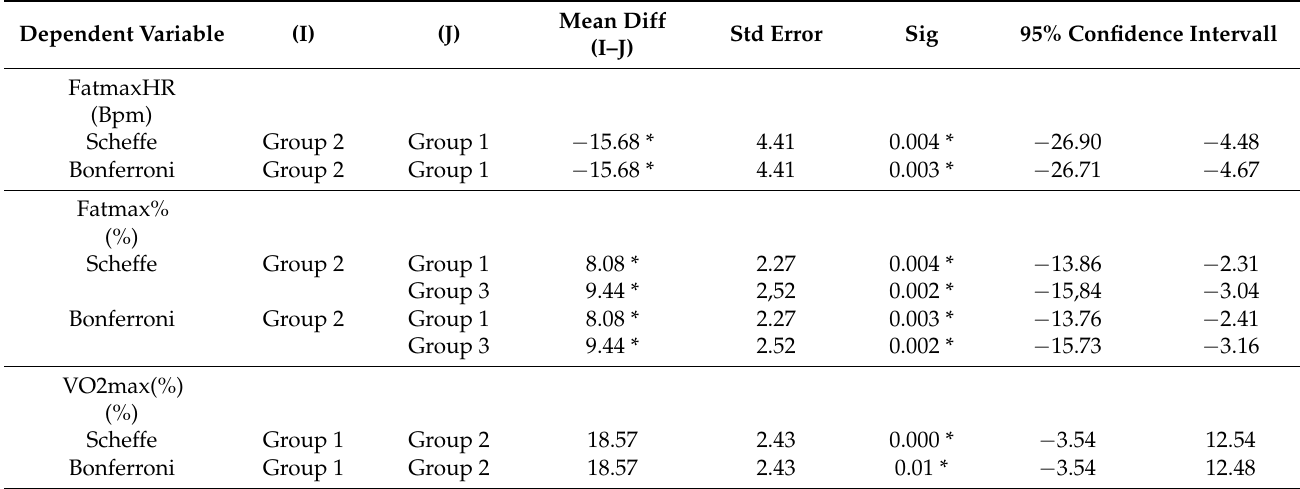
Figure 2. VO2max results of the groups (* p <0.05). Figure 3. Fatmax% results of the groups (* p <0.05).